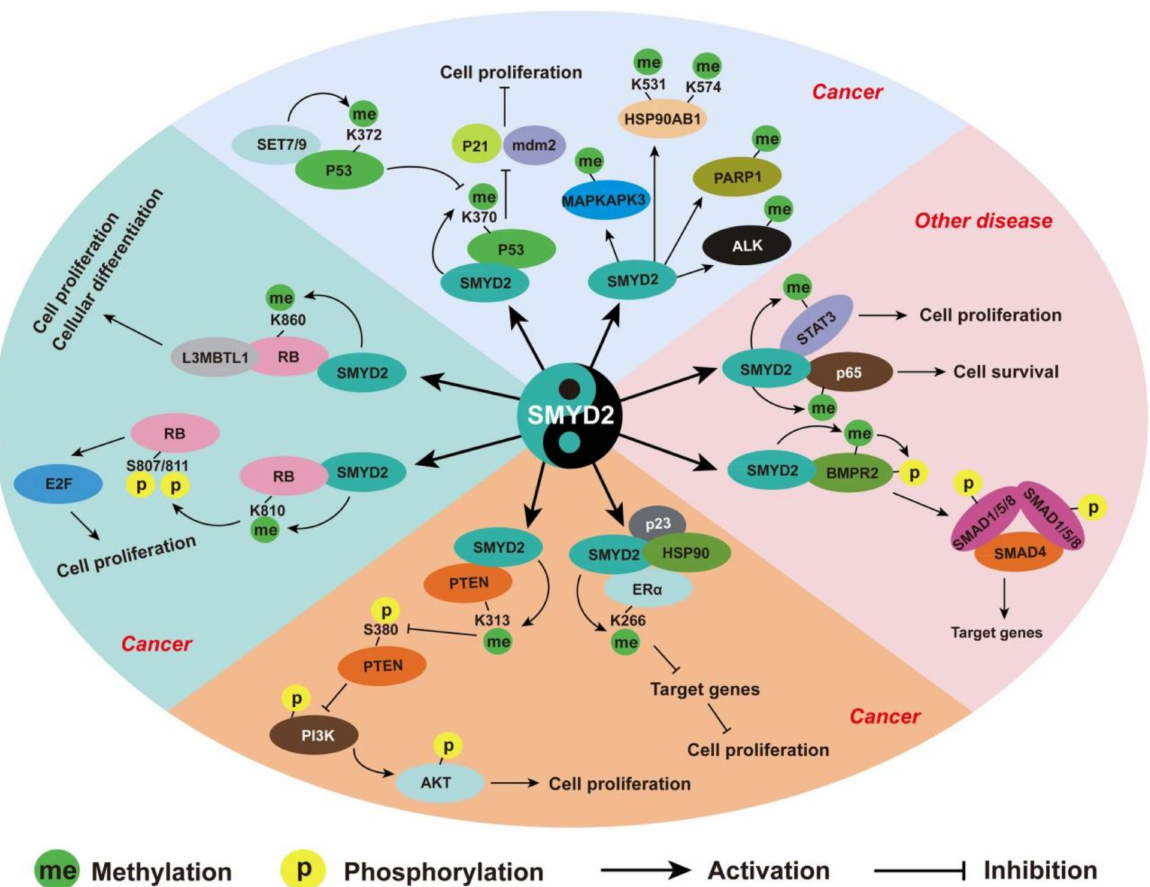
Figure 5. SMYD2 is involved in cancers and other diseases via the methylation of nonhistone substrates. Proteins methylated by SMYD2 during cancer development include p53, RB, PTEN, ALK, MAPKAPK3, HSP90AB1, ER α , and PARP1. SMYD2 methylates and activates p65 and STAT3 to regulate autosomal dominant polycystic kidney disease. The methylation of BMPR2 by SMYD2 activates SMAD1/5 signaling. The methylation of substrates also leads to crosstalk between signaling pathways undergoing other posttranslational modifications, particularly phosphorylation. This affects cell proliferation and differentiation and target genes related to cancer and other diseases. Adopted with permission from Ref.